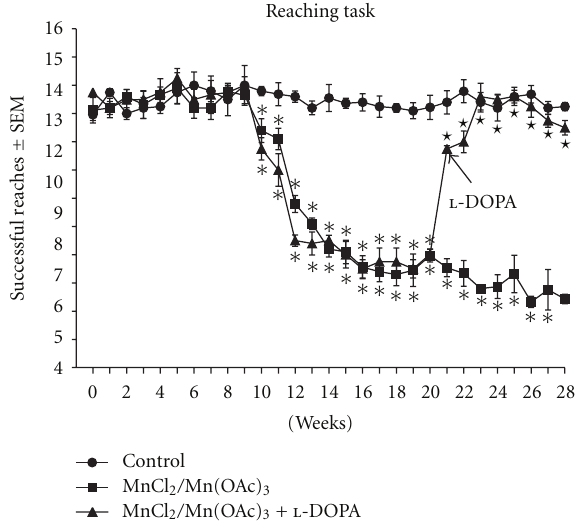
Figure 3: Reaching success (number of pellets obtained out of 20; mean ± SEM) by control, Mn exposed and Mn exposed + l -DOPA treatment mice in the single-pellet task before and after inhalation and after l -DOPA treatment. Note that the Mn-exposed group is impaired since 8 week and the l -DOPA treatment fully reverses the alterations ( ∗ P < . 001 versus control group; (cid:2) P < . 001 between l -DOPA treatment group versus Mn exposed